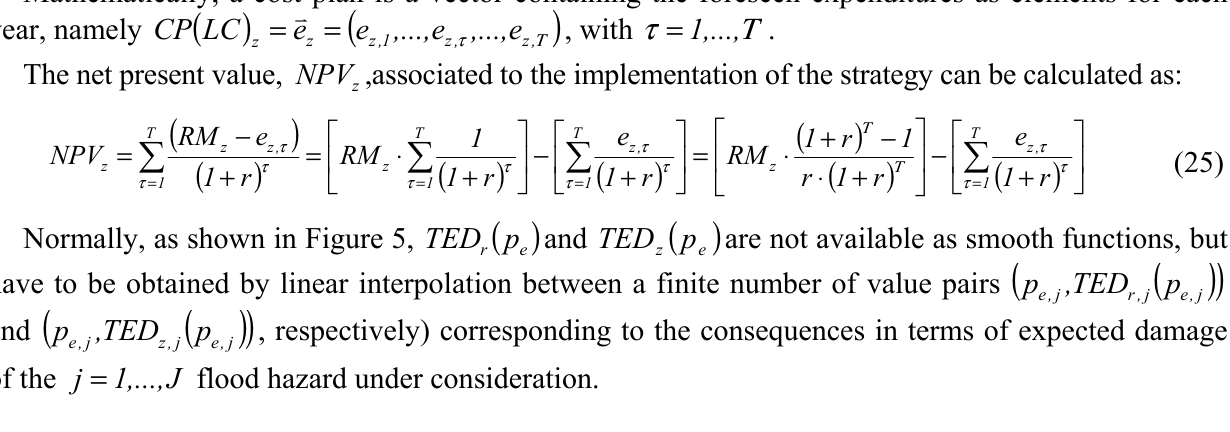
RM of a mitigation z